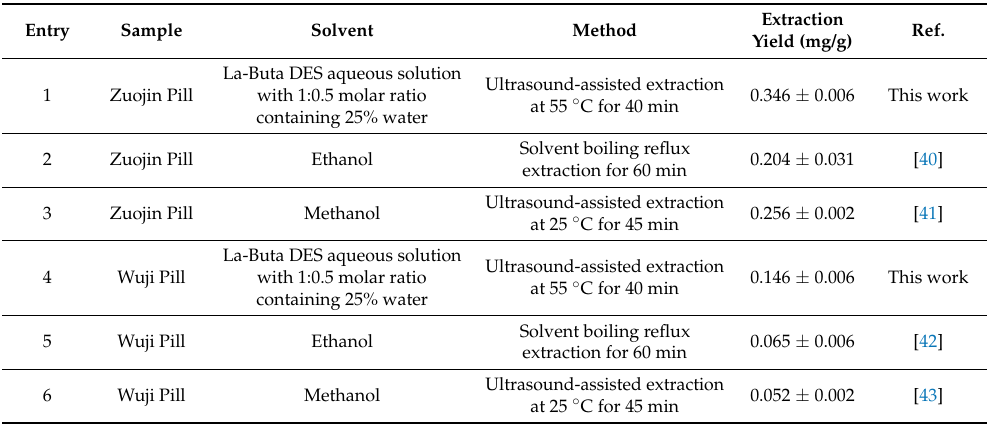
Figure 11. Typical HPLC chromatograms of ( A ) extract of Zuojin Pill and ( B ) extract of Wuji Pill. HPLC conditions: Column, Zorbax SB-C18 250 mm × 4.6 mm I.D.; column temperature, 35 °C; mobile phase, water with 0.2% phosphoric acid ( A ) and acetonitrile ( B ); gradient program, 0–20 min, 10–30% B; 20–60 min, 30–70% B; 60–70 min, 70% B; flow rate, 1.0 mL/min, detection wavelength, 345 nm. Table 6. Comparison of the method developed in this work with other extraction procedures for extraction of rutaecarpine in the Zuojin Pill and Wuji Pill.